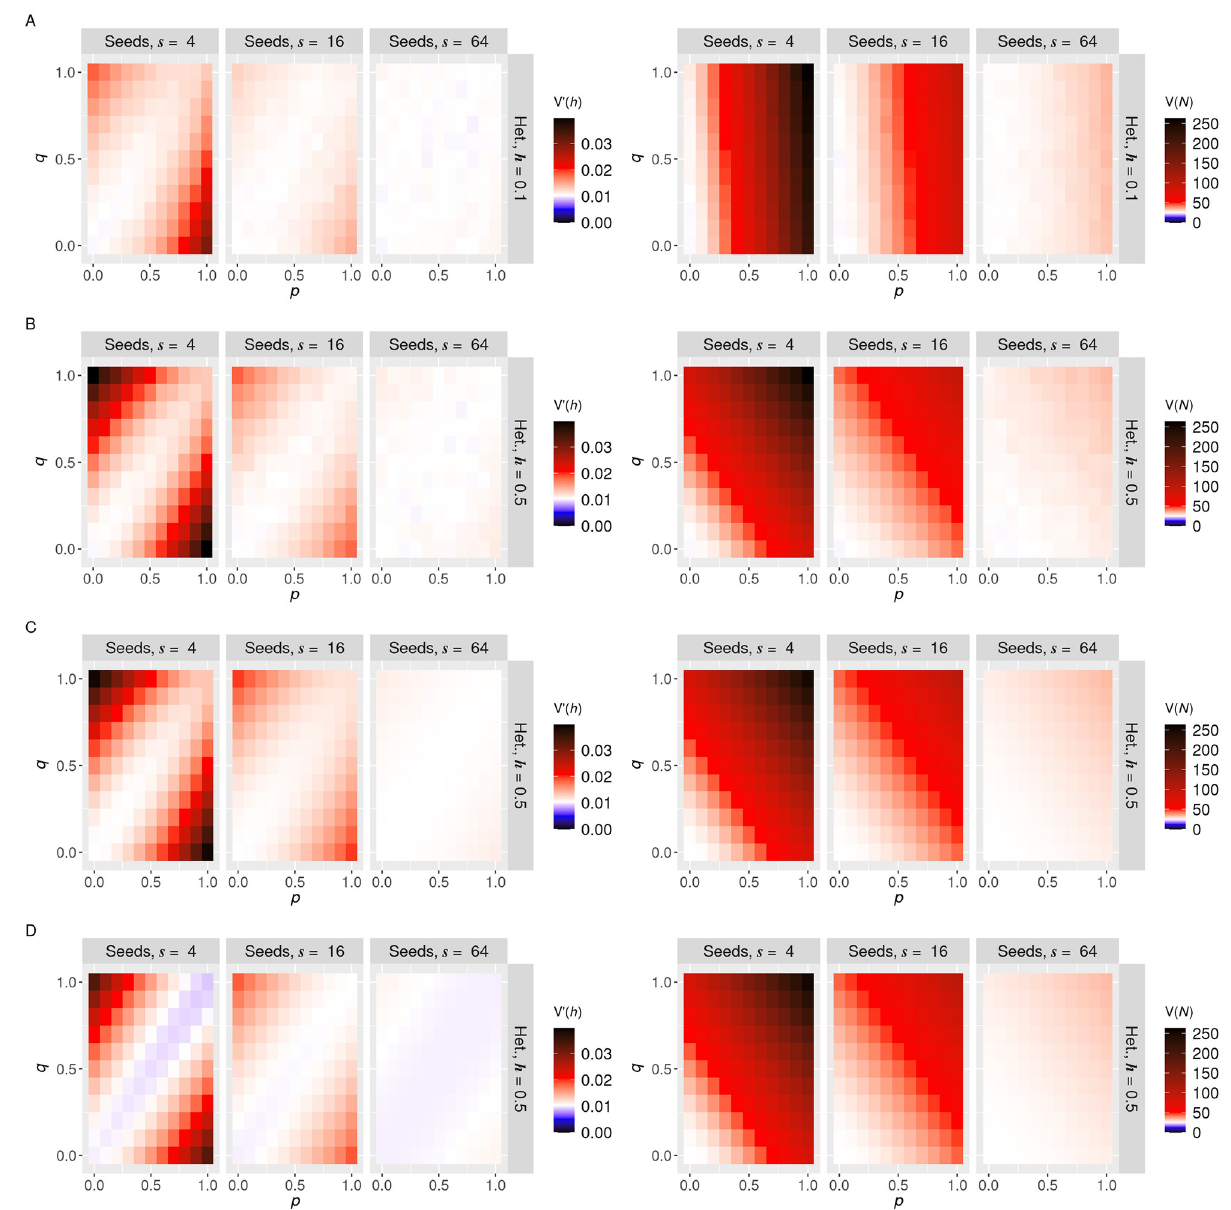
Fig 2. Genetic bias and physical heterogeneity in mitochondrial networks induce cell-to-cell mtDNA variability in symmetric cell divisions. Normalised heteroplasmy variance V 0 ( h ) (left column) and copy number variance V ( N ) (right column) for N = 100 mtDNA molecules randomly distributed in networks. A : simulations for h = 0.1; B : simulations for h = 0.5; C : sum over state variables for h = 0.5; D : first-order Taylor expansion for h = 0.5. The three columns for each panel give decreasing network heterogeneity, expressed via different seed numbers, 4, 16 and 64 (more seed points give a more homogeneous network). In each panel, variances are given for different values of wild and mutant type network inclusion parameters p (horizontal axis) and q (vertical axis). White baseline reflects the null case from the analytic sum without any network inclusion.